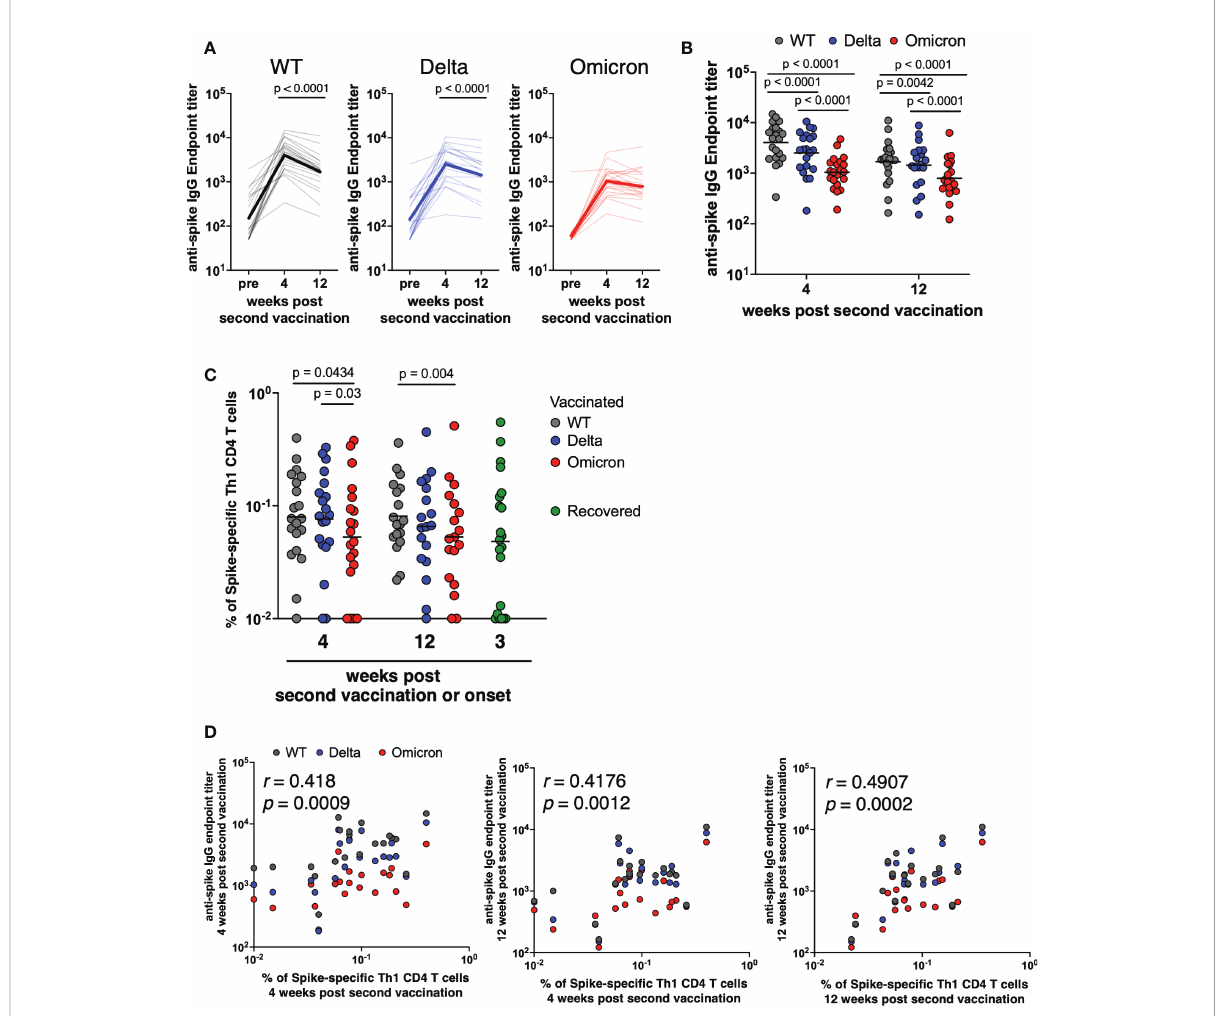
FIGURE 1 Antibody and CD4 + T cells induced by mRNA vaccine against SARS-CoV-2 variants of concern. (A) Anti-spike IgG against WT (pre; 50 – 1968.3, GMT = 150.2, 4 weeks; 335.7 – 14742.2, GMT = 4031.9, 12 weeks; 164.3 – 11003, GMT = 1682.7; left panel), Delta (pre; 50 – 2560.4, GMT = 141.9, 4 weeks; 181.6 – 10495.7, GMT = 2514.2, 12 weeks; 151.2 – 8781.6, GMT = 1435.2; center panel), and Omicron (pre; 50 – 1693.8, GMT = 61.1, 4 weeks; 190.5 – 4704.7, GMT = 1041.6, 12 weeks; 122 – 6260.4, GMT = 790.4; right panel) endpoint titers over time in plasma samples obtained from BNT162b2-vaccinated individuals ( n = 21). P -values were calculated using the Wilcoxon matched-pairs signed rank test. (B) Comparison of anti-spike IgG endpoint titer against WT, Delta, and Omicron spike proteins at 4 and 12 weeks post second vaccination ( n = 21). P -values were calculated using the Wilcoxon matched-pairs signed rank test. (C) Comparison of spike-speci fi c Th1 cell frequency against WT (4 weeks; 0.01% – 0.399%, geometric mean = 0.080%, 12 weeks; 0.022% – 0.361%, geometric mean = 0.081%), Delta (4 weeks; 0.01% – 0.329%, geometric mean = 0.076%, 12 weeks; 0.01% – 0.451%, geometric mean = 0.066%), and Omicron (4 weeks; 0.01% – 0.379%, geometric mean = 0.053%, 12 weeks; 0.01% – 0.511%, geometric mean = 0.053%) spike peptides in CD4 + total memory cells at 4 and 12 weeks post second vaccination ( n = 21) and spike-speci fi c Th1 cell frequency against Alpha spike peptides in CD4 + total memory cells from recovered donors (0.01% – 0.55%, geometric mean = 0.048%; n = 21). P -values were calculated using the Wilcoxon matched-pairs signed rank test. (D) Correlation of anti-spike IgG endpoint titer and spike-speci fi c Th1 cell frequency against WT (black), Delta (blue), and Omicron (red) spike peptides ( n = 21). Correlations were calculated using the nonparametric Spearman ’ s rank